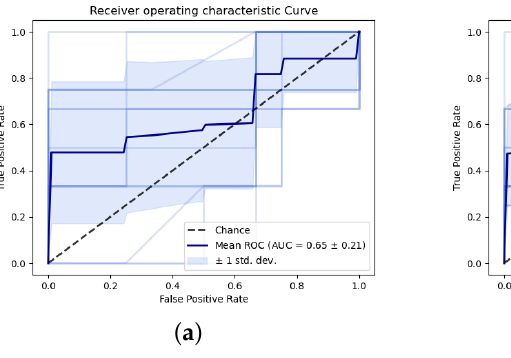
Figure 4. Receiver Operating characteristic curve for ( a ) PCA–LDA ( b ), SVM ( c ), CNN. Bold lines indicate mean ROC, pale lines performance for individual folds and shaded area 1 standard